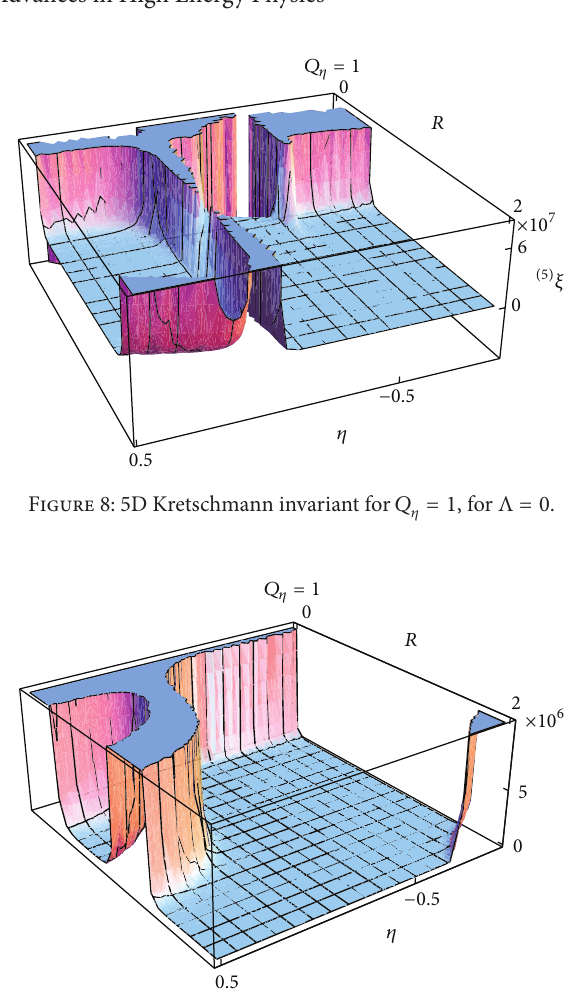
Figure 9: 4D Kretschmann invariant 𝜉 for 𝑄 𝜂 = 1 , for Λ = 1 .